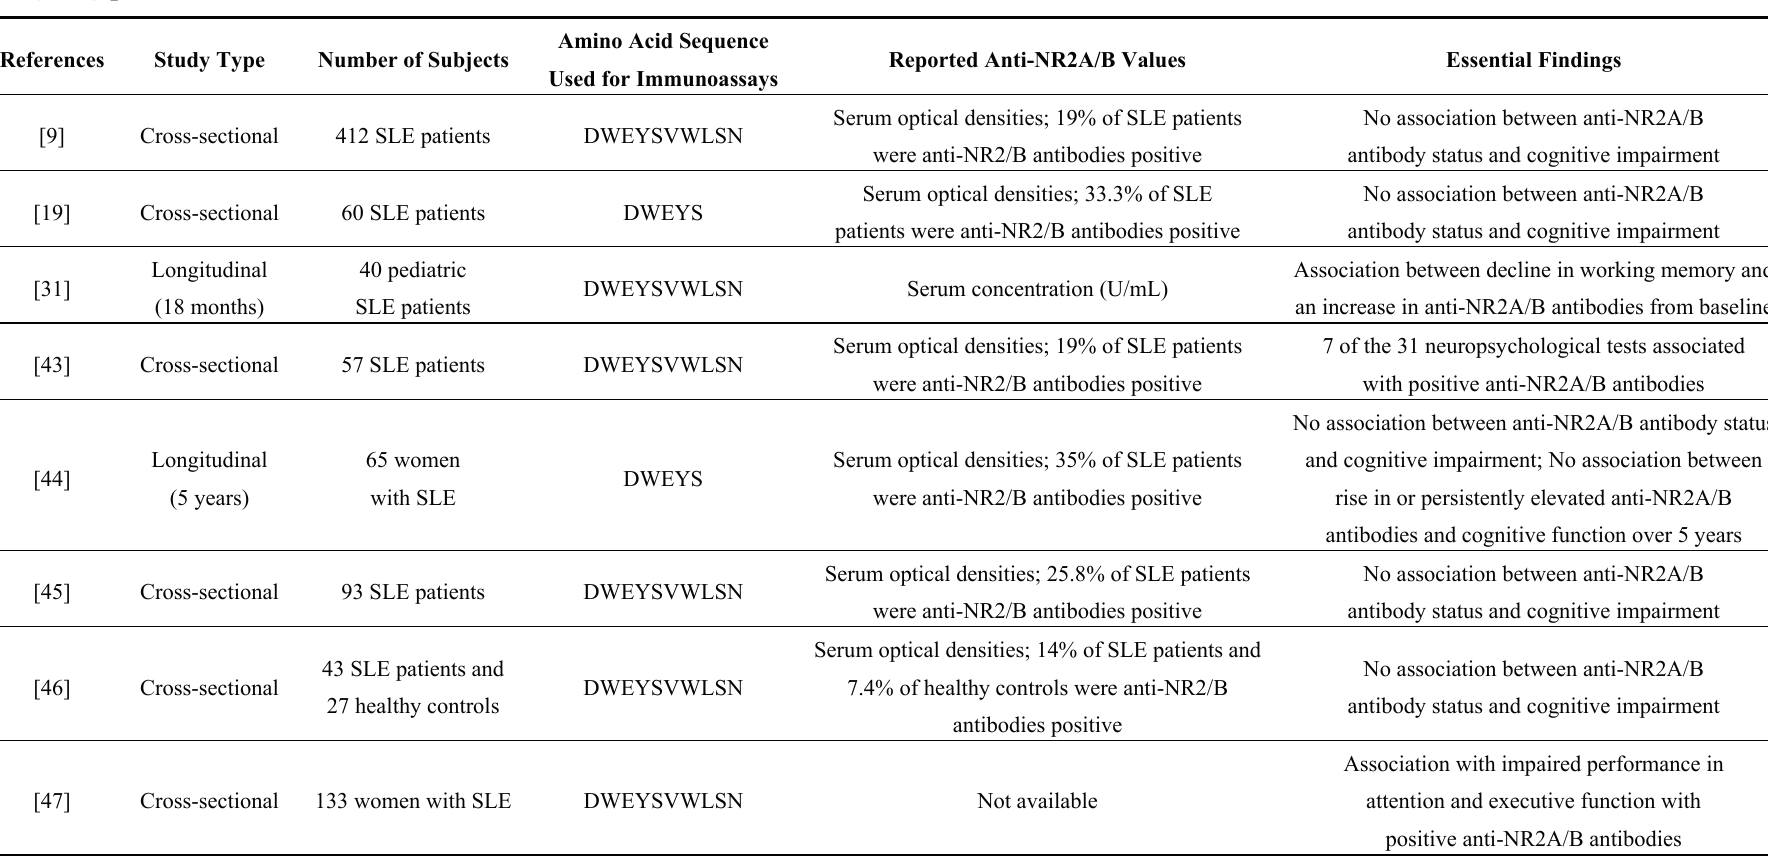
Table 1. Human studies on the association between anti-NR2A/B antibodies and cognitive dysfunction in systemic lupus erythematosus (SLE)